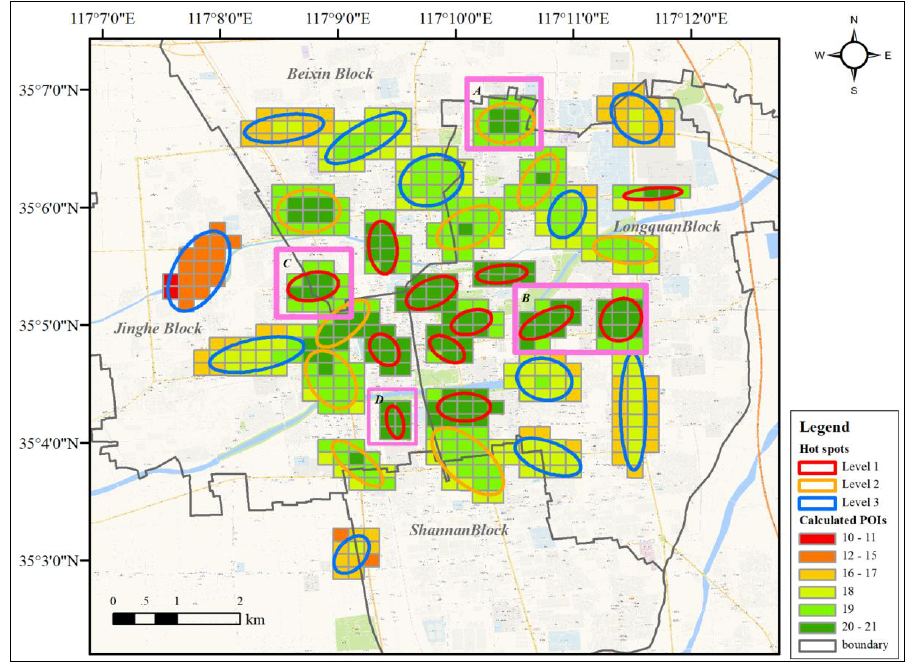
Figure 9. Delineated results of residential areas based on the Commuting Activity and Residential Area (CARA) model. (CARA)